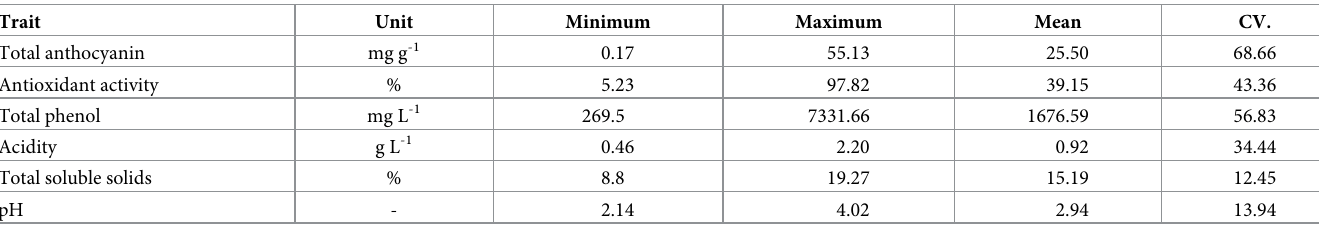
Table 2. Descriptive statistics of the biochemical traits of 152 pomegranate